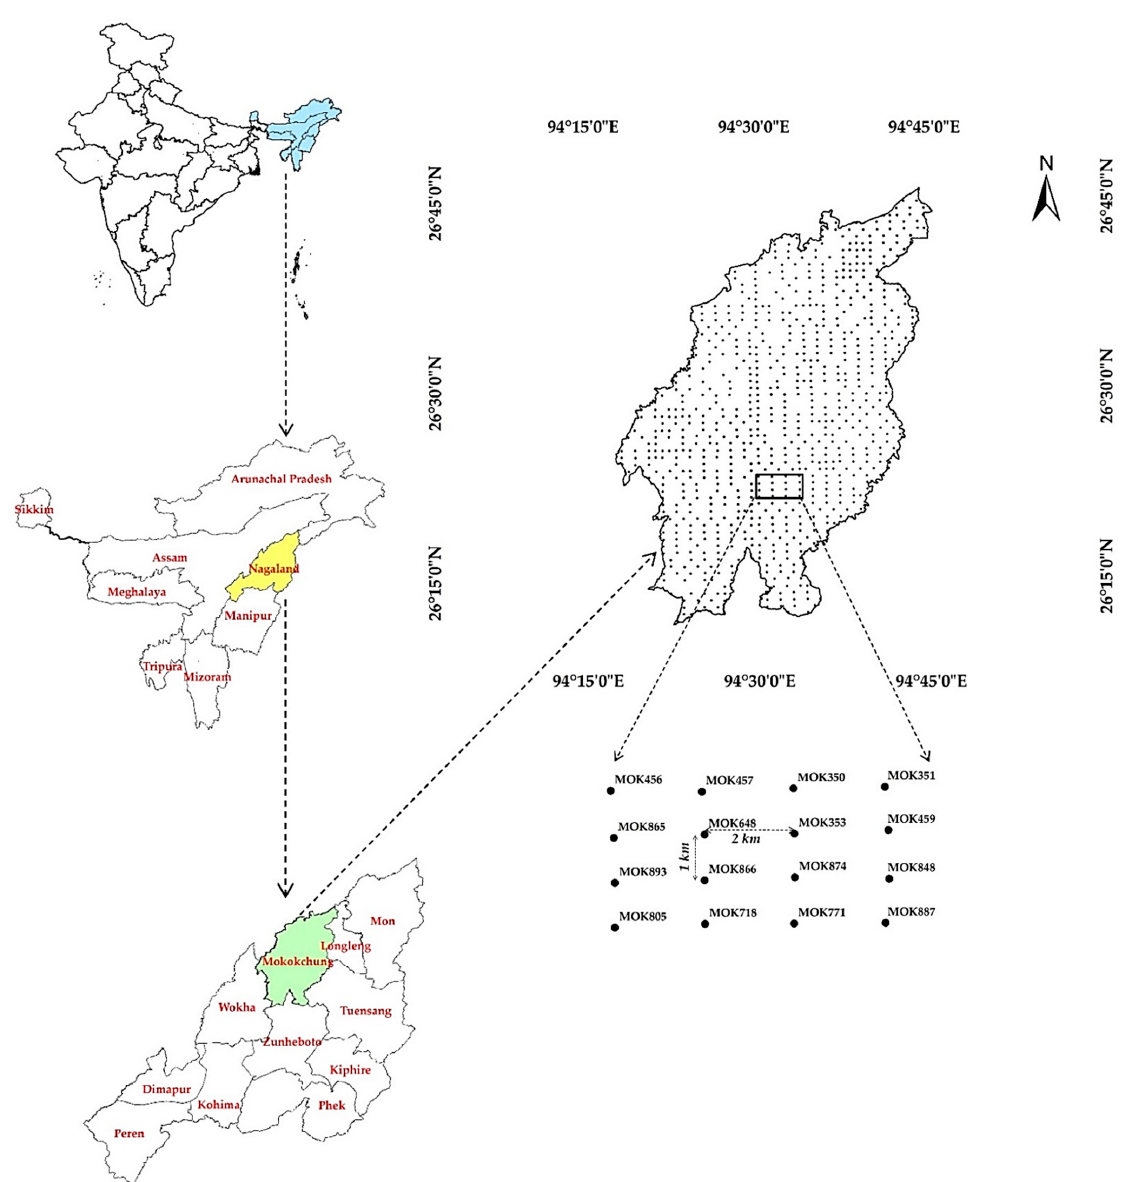
Figure 1. Study area located in Nagaland state, India’s north-eastern Himalayan region, and adopted grid sampling scheme.